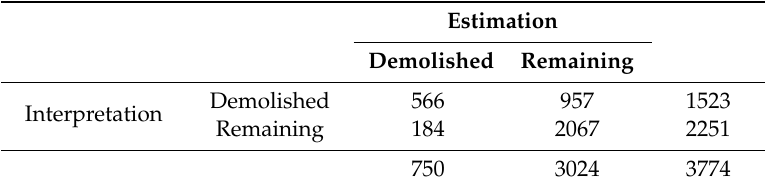
Table 11. Relationship between the building area ≤ 60 m 2 and the estimation classification by the indicator of 0.3 in the 25 March 2018 image.